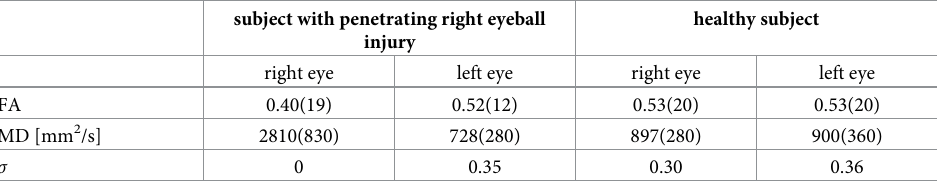
Table 1. Fractional anisotropy (FA), mean diffusivity (MD) in the optic nerve and σ threshold value for with the optic nerve is removed from the image.